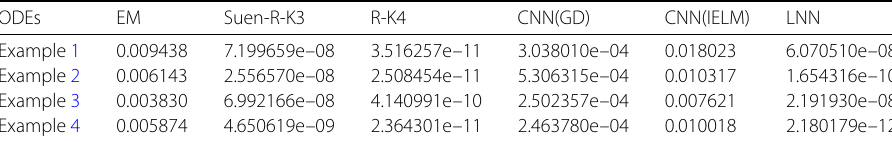
Table 3 Mean absolute deviation of different methods for first-order ODEs